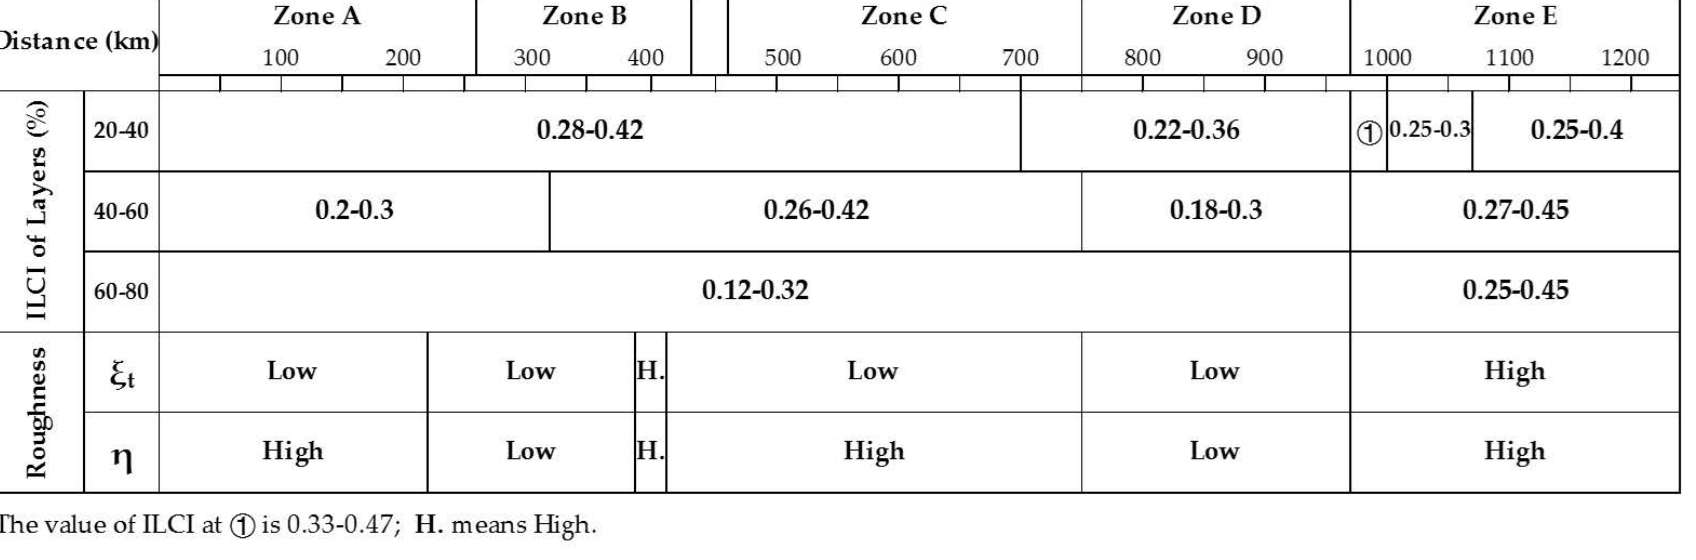
Figure 7. Distribution of Internal Layering Continuity Index (ILCI) with depth and three types of the basal roughness along the traverse from Zhongshan to Dome